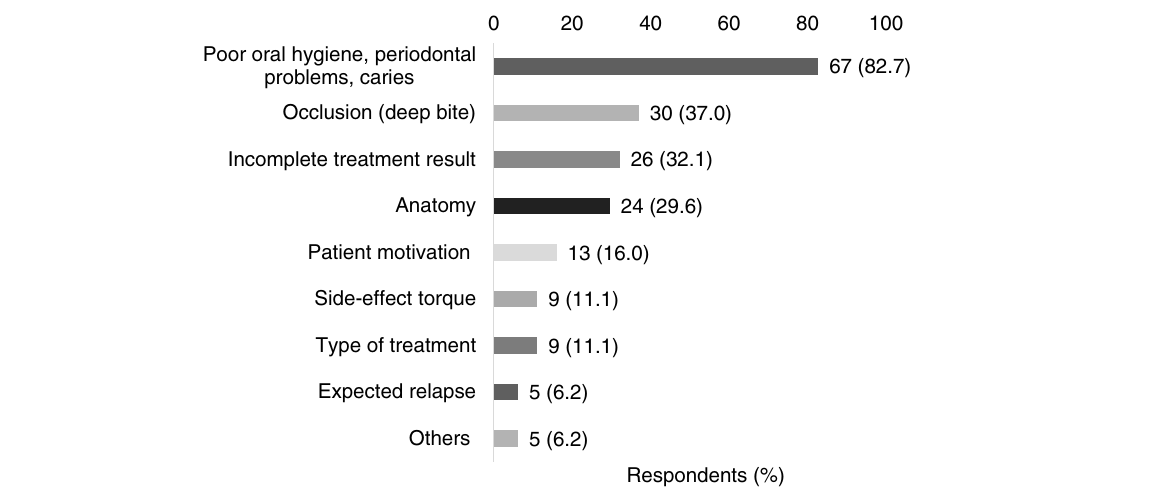
Fig. 2 Absolute numbers and percentage of the respondents who mentioned the contraindications for using fixed